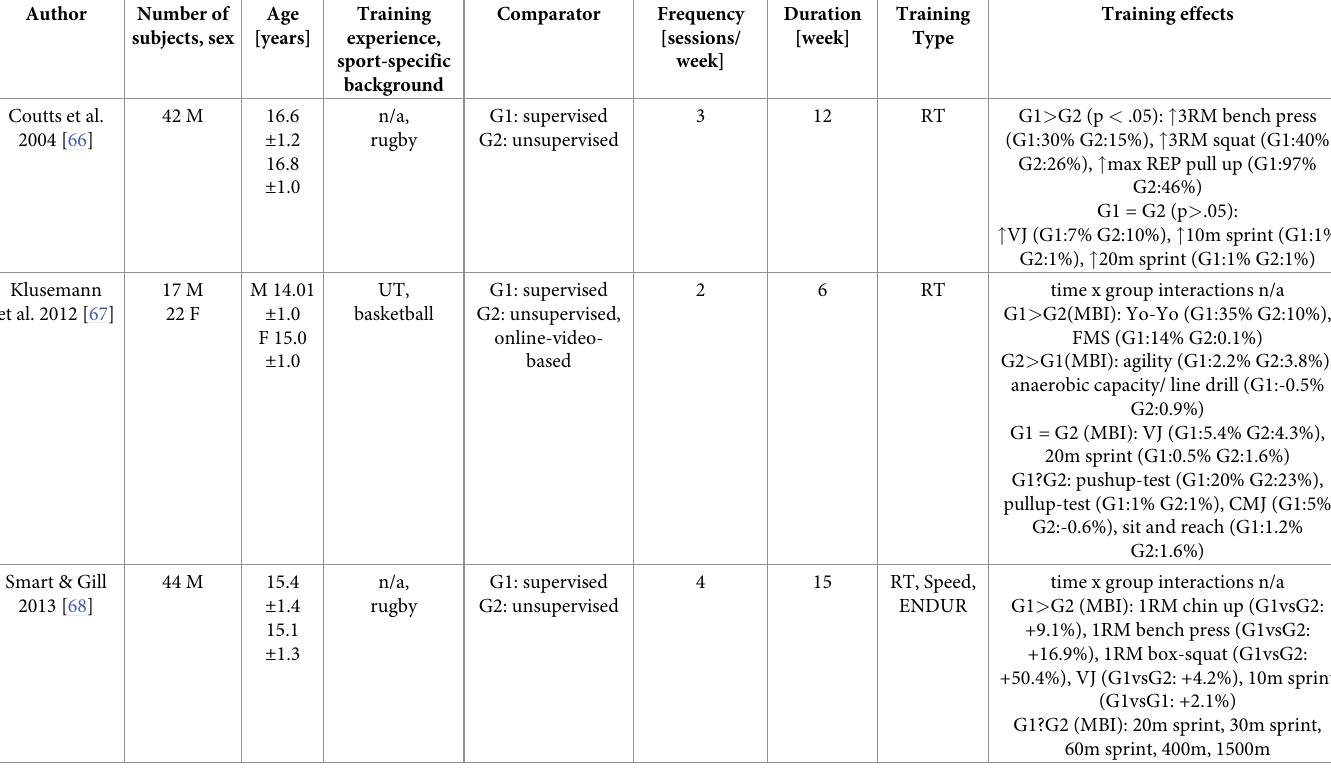
Table 7. Influence of the moderating variable ‘supervision’ on resistance training induced improvements in components of physical